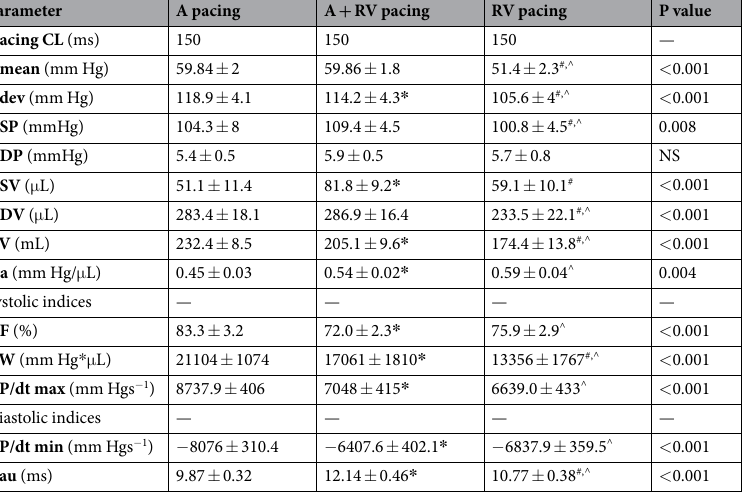
< 0.001 Table 1. PV loop analysis of rats implanted with RA and RV pacing electrodes. Repeated P-V loop measurements in rats under atrial (A), sequential atrial and RV (A + RV) and RV only pacing modes (n = 8 for all). Statistical analysis was performed using non-parametric repeated measure ANOVA (Friedman test). Symbols indicate significant difference in post-test analysis; * RA + RV vs. RA (ventricular dyssynchrony component), # RV vs. RA + RV (AV physiology component), ^ RV vs. RA (combined ventricular dyssynchrony and AV physiology components). Pmean = mean pressure; Pdev = developed pressure; ESP -end systolic pressure; EDP -end diastolic pressure; ESV = end systolic volume; EDV = end diastolic volume; SV = stroke volume; Ea = arterial elastance; EF = ejection fraction SW = stroke